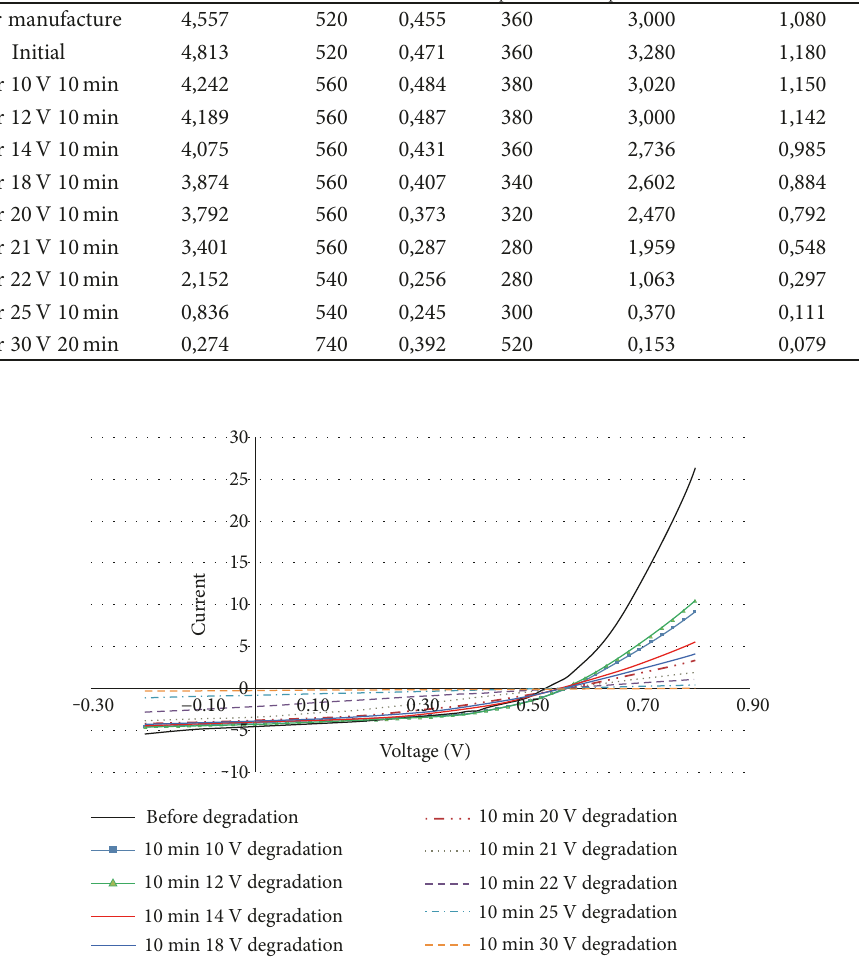
Figure 8: Device 4 fi nger 2 voltage-dependent degradation I – V curves.